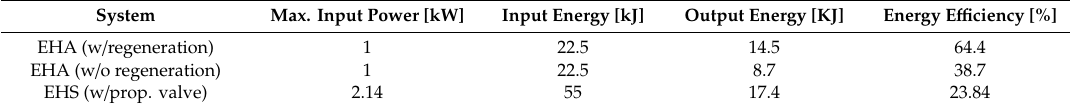
Table 4. Comparison of actuation systems in terms of energy consumption and efficiency.